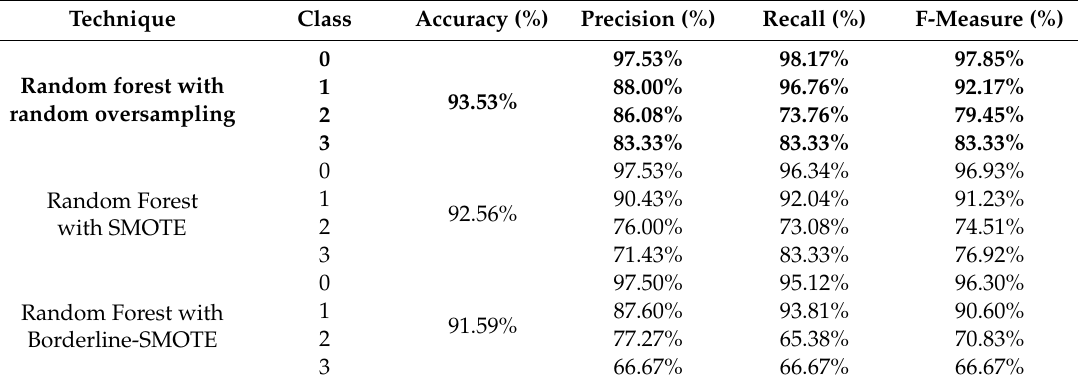
Table 6. Performance in terms of prediction with oversampling techniques used to handle imbalanced data. SMOTE, synthetic minority oversampling technique.